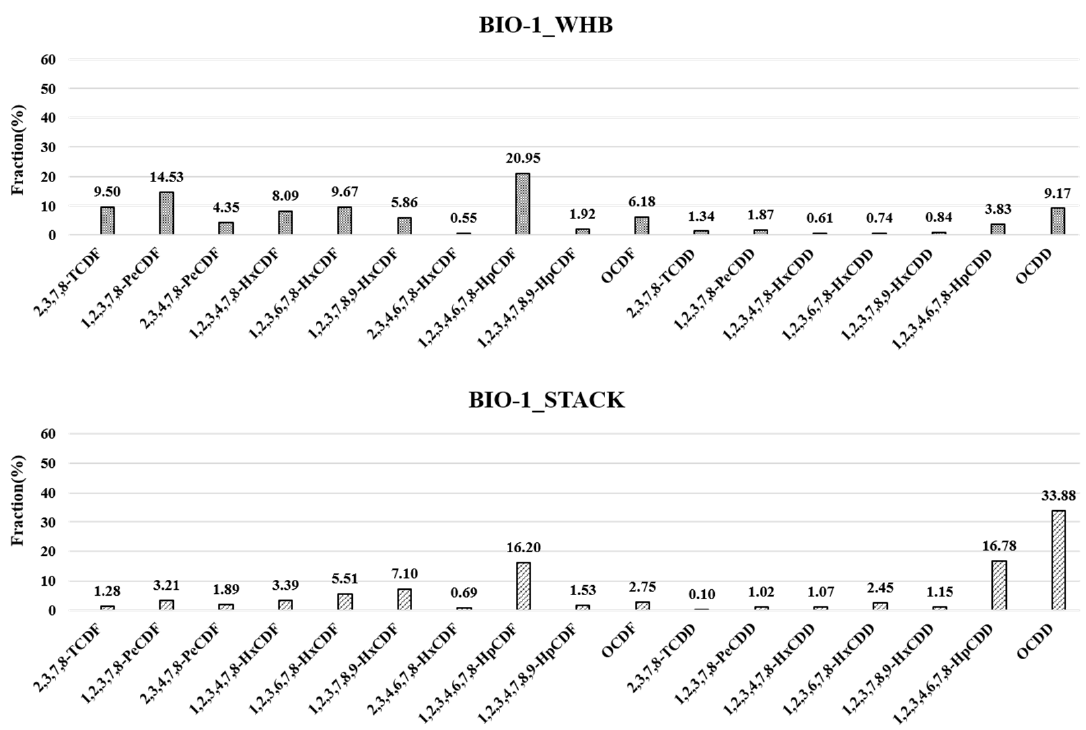
Figure 3. PCDD/DFs congener pattern in Bio-1 incineration plant.